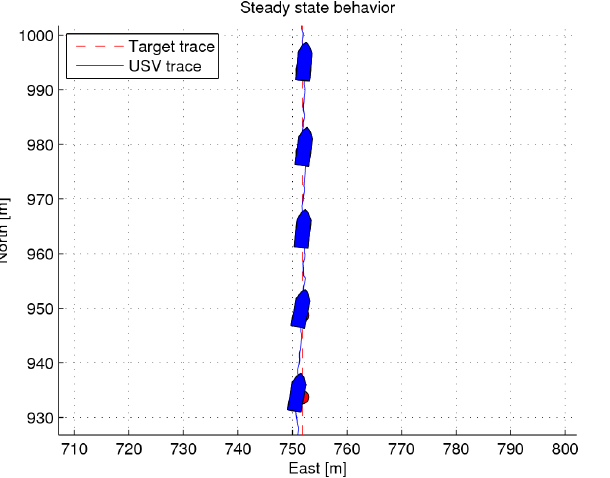
Figure 16: Top: The surge speed response of the Kaas- bøll USV. Bottom: The yaw rate is seen to remain within the bounds of  a  max